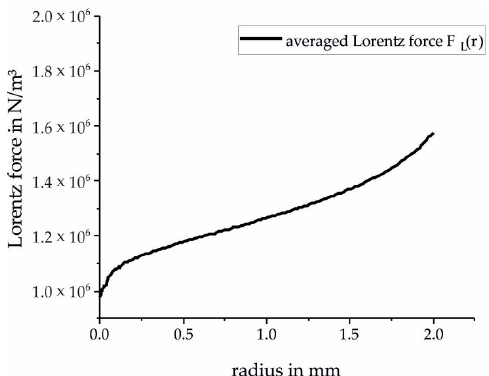
Figure 10. The numerical Lorentz forces in x- and y-directions ( a ) and z-direction ( b ).